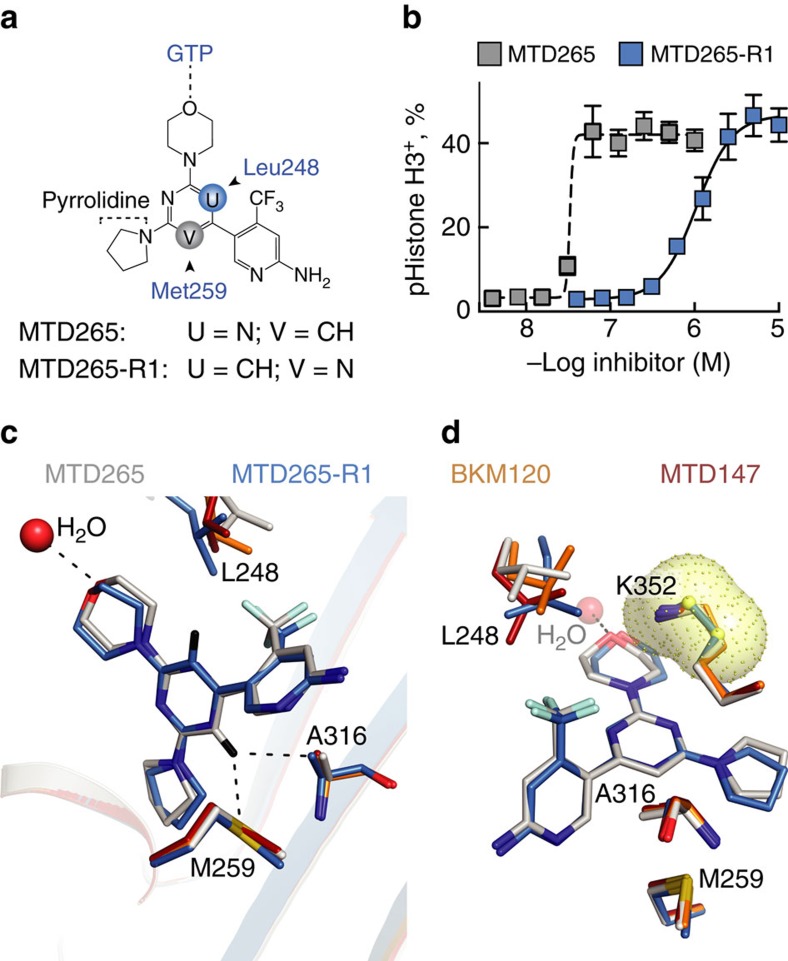
Determination of core pyrimidine orientation in tubulin complexes.(a) Chemical formulas and schematic orientation of BKM120 regioisomeric derivatives MTD265 (PDB ID 5M8G) and MTD265-R1 (PDB ID 5M8D) in tubulin. (b) Phospho-Histone H3-positive A2058 cells triggered by increasing concentrations of MTD265 (grey) or MTD265-R1 (blue; % of total cells, n=3, mean±s.e.m.). (c,d) Structural overlay of amino acid side chains relevant for pyrimidine core ring interactions with BKM120 (orange), MTD147 (red), MTD265 (grey) and MTD-265-R1 (sky blue) in stick representation. The indicated water molecule is oriented towards the GTP-binding site (c) Visualization of βMet259 and βAla316 interactions with the pyrimidine core of MTD265 and MTD-265-R1 (core C–H protons shown in black). (d) βLys352 cation in proximity to pyrimidine core π-system of MTD265 and MTD-265-R1. The βLys352 side chain is fully resolved in crystal structures of BKM120, MTD265 and MTD147, but is poorly defined in MTD265-R1 complex beyond the δCH2 of βLys352 (yellow spheres and cloud denote poorly defined atoms).